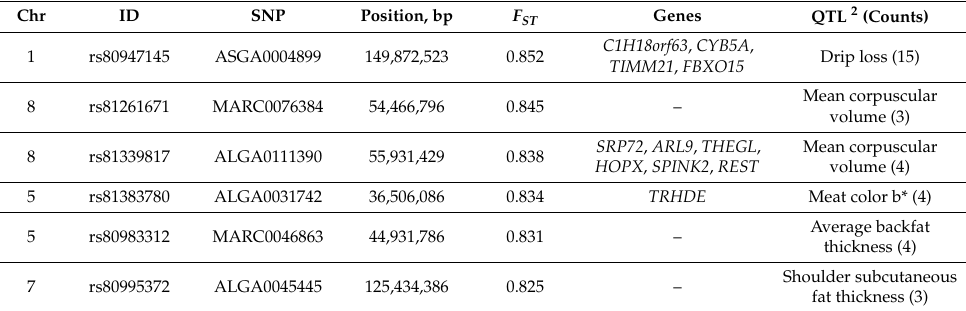
Figure 7. Genome-wide distribution of selection signatures detected by F ST statistics across all autosomes in South China pig breeds, Western commercial pig breeds, and European and Asian wild boar. The SNPs above the red line were the significant SNPs detected in this study. Table 2. Summary of significant SNPs detected by F ST 1 .